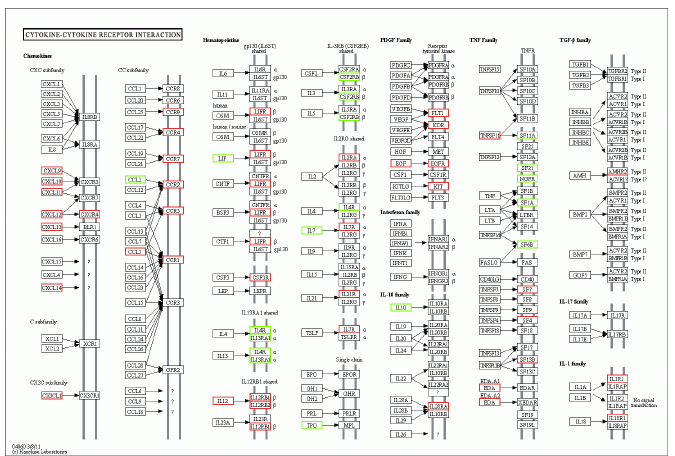
Fig 1. Differentially expressed genes participating in cytokine – cytokine receptor interaction pathway. Genes enclosed in red boxes are up-regulated, whereas those in green boxes are down-regulated in the mammary gland tissues of mastitis-infected with respect to those in the mammary gland tissues of healthy cows.